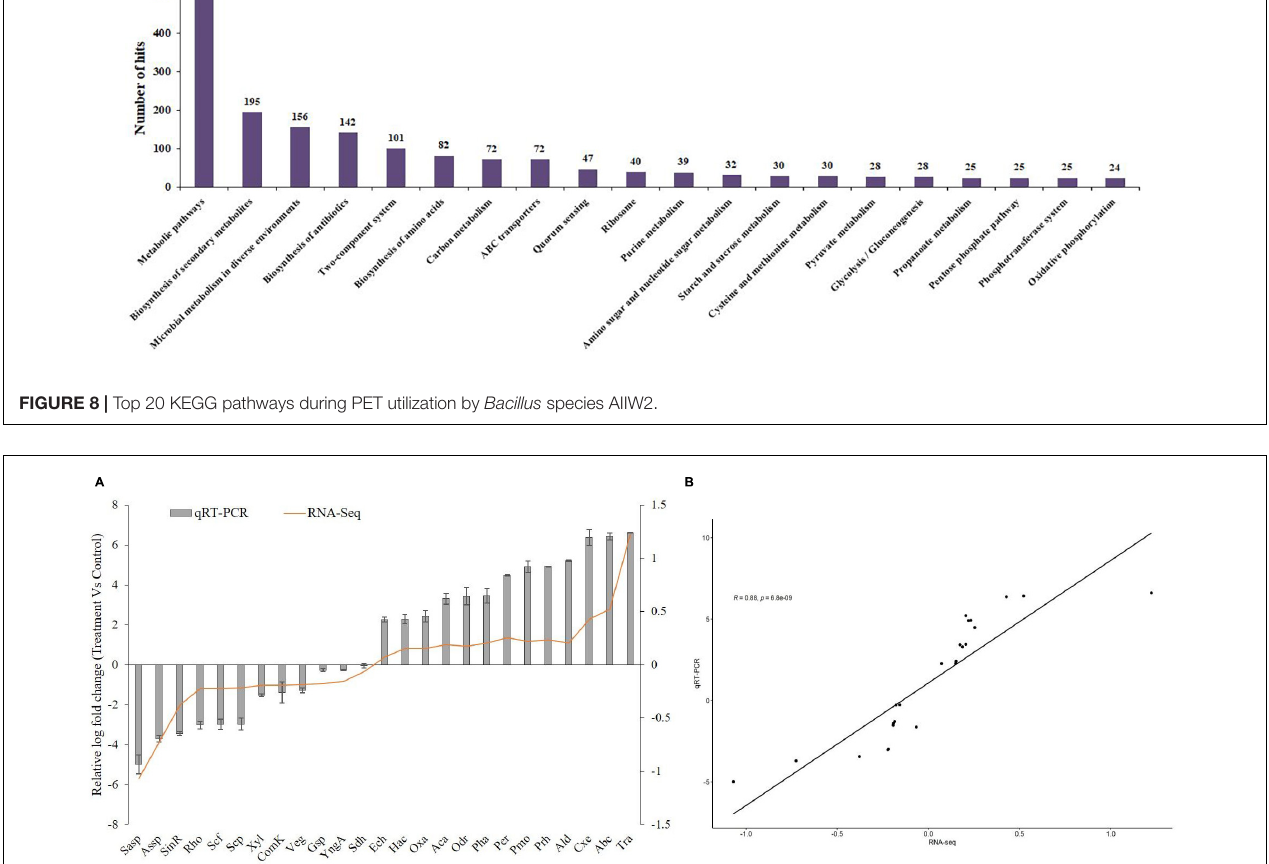
FIGURE 9 | Quantitative RT-PCR of DEGs of Bacillus species AIIW2 when grown with PET film compared with culture grown without PET film (A) . Correlation analysis between qRT-PCR and RNA-Seq data expression values (B) . The R and p represent the Pearson correlation coefficient and p value, respectively.